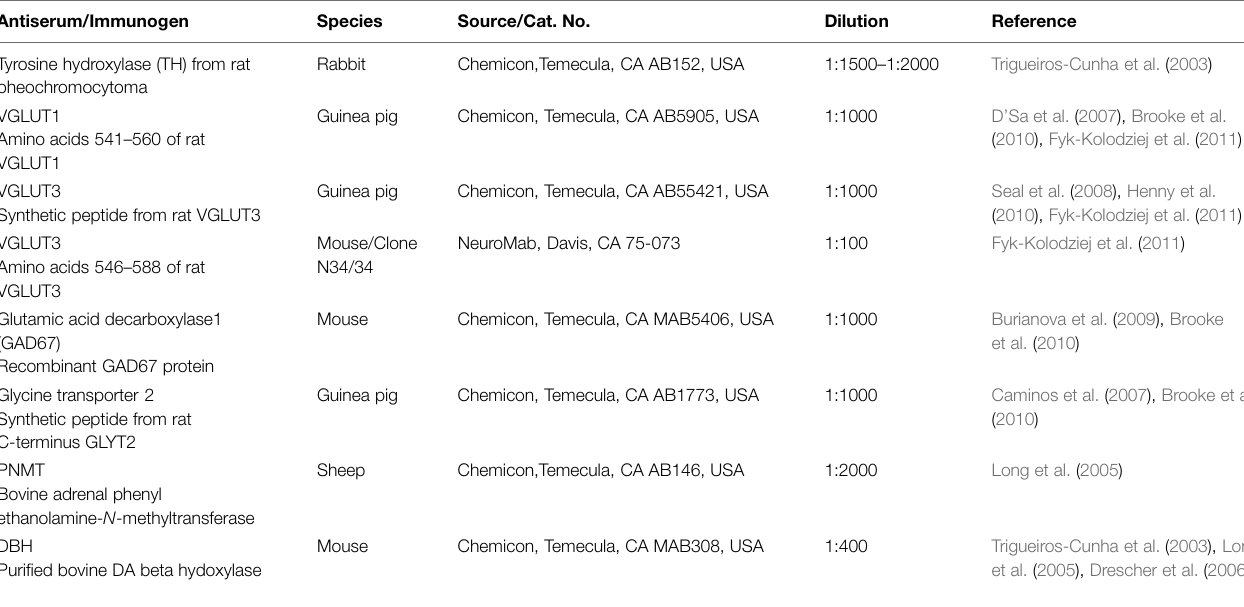
TABLE 1 | Antibodies.